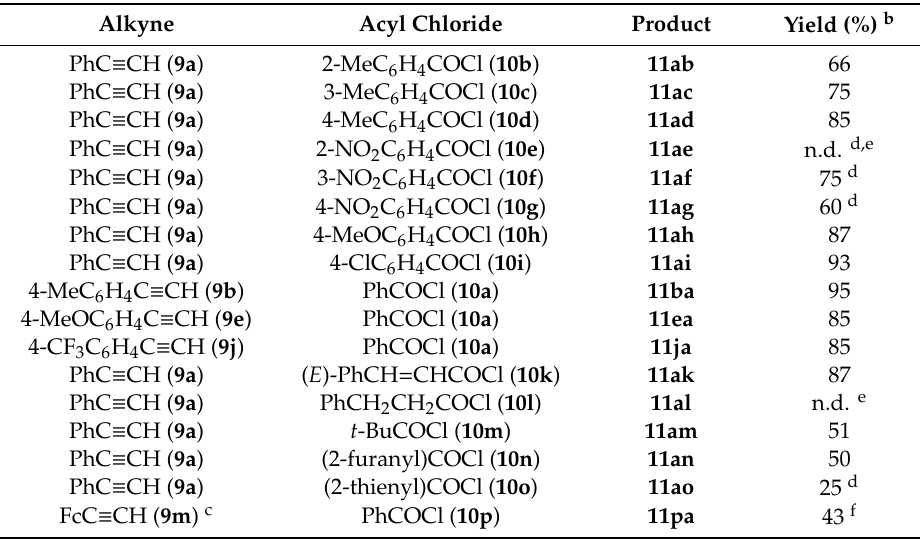
Table 1. Summary of the reaction scope tests a